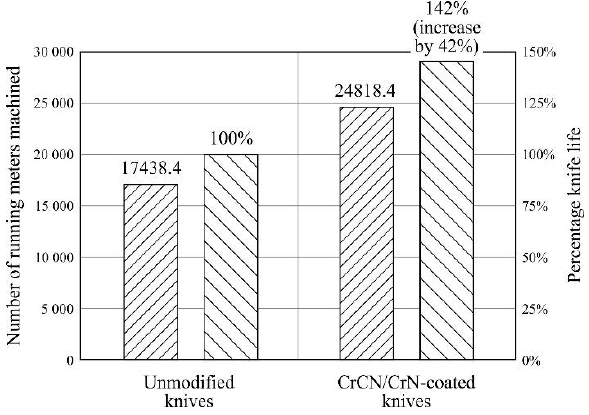
Figure 6. Comparison of the number of running meters of material machined using CrCN/CrN-coated and reference knives (unmodified) after operational tests carried out under industrial conditions.